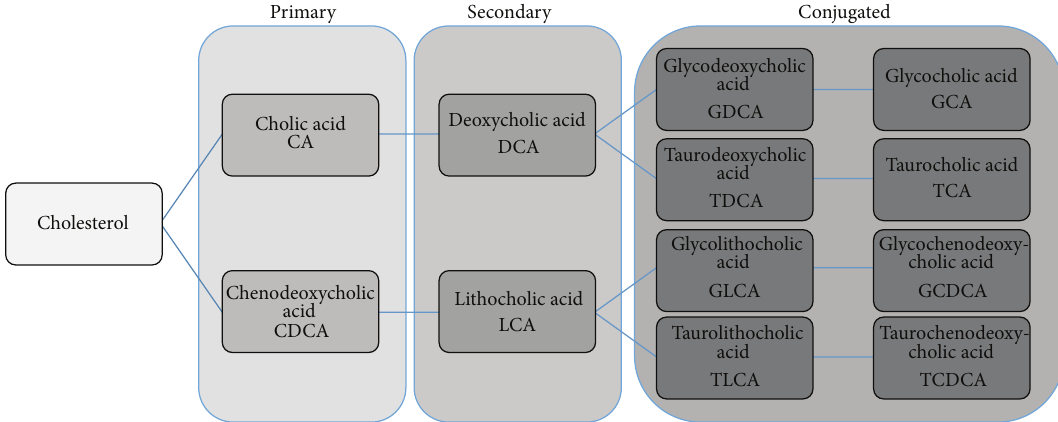
Figure 1: Major bile acids. The primary bile acids are synthesized from cholesterol in the liver. Secondary bile acids are formed by dehydroxylation of primary bile acids by intestinal bacteria. Primary and secondary bile acids can also undergo conjugation with taurine or glycine in the liver.